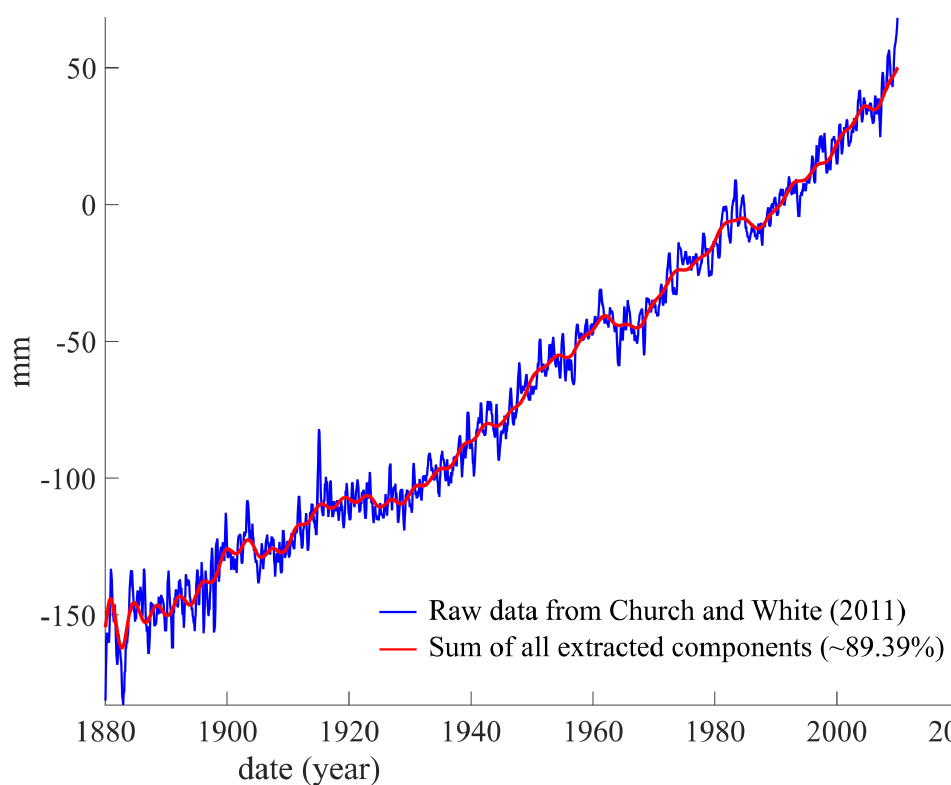
Figure 8. Global sea level GSLl curve from [27] in blue. Sum of first 6 components extracted by SSA , red